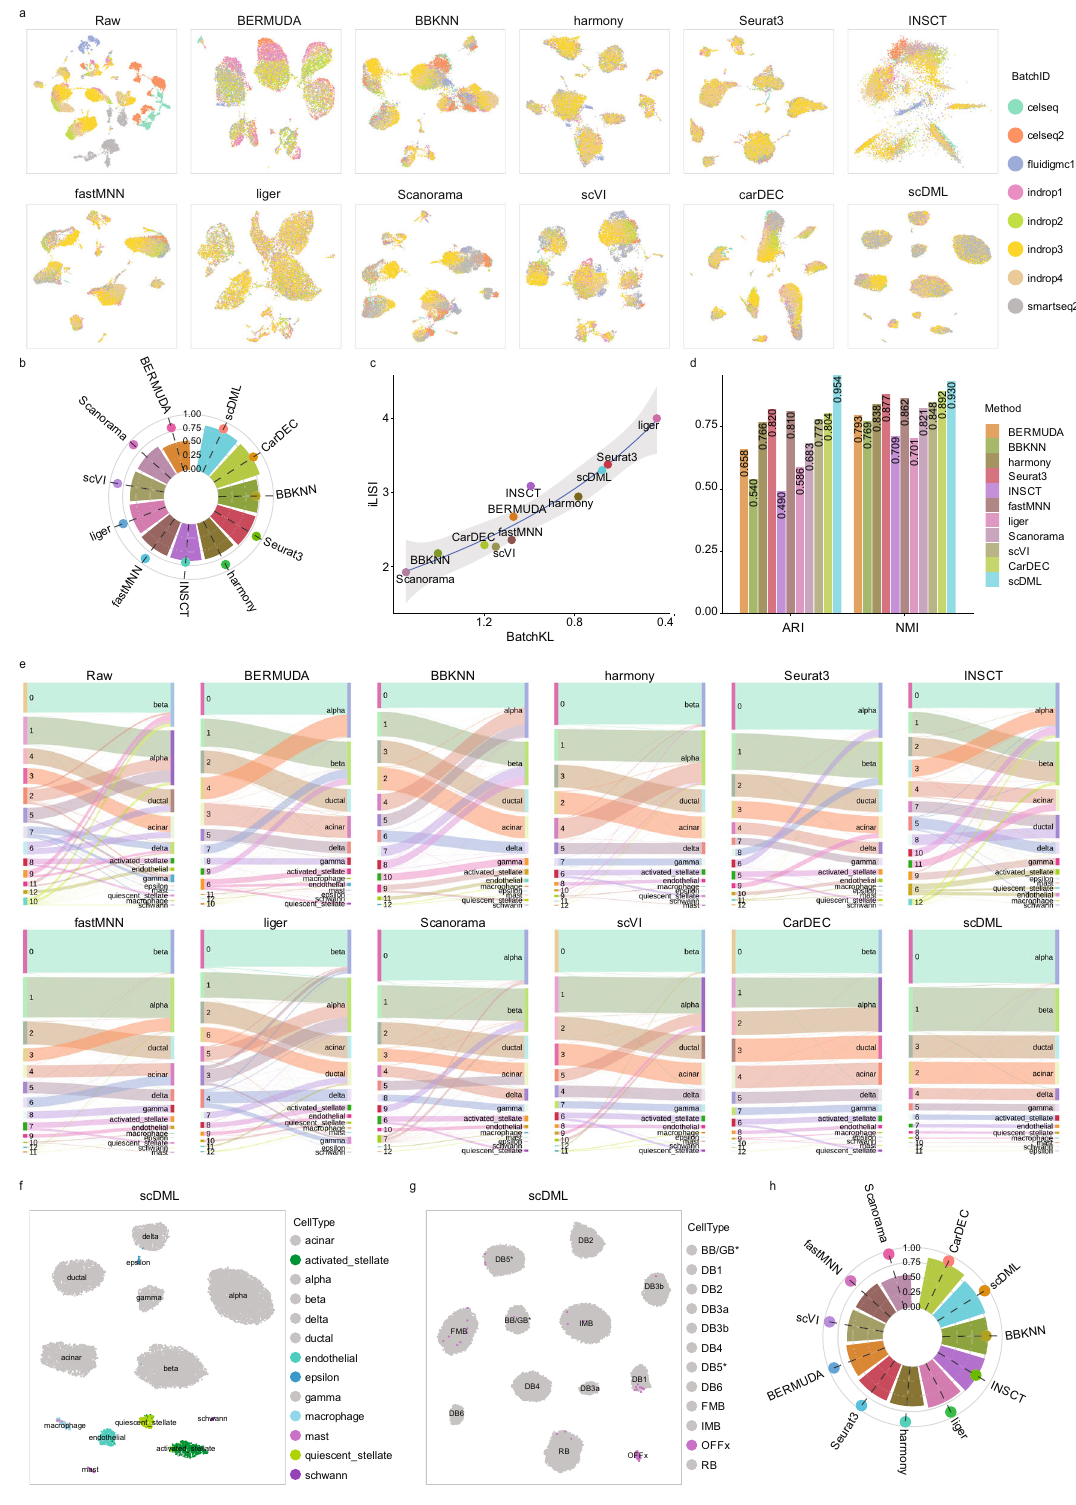
scDML was the best method that separated neurons from other cell types (Fig. 5a, b) and generated the most isolated clus- ters (Fig. S11a) with the overwhelming highest ARI and NMI (Figs. 5c, S11d). The metrics BatchKL and iLISI of scDML were only inferior to Liger (Fig. S11c), but Liger sacri fi ced clustering accuracy (Fig. 5c). Other compared methods failed to maintain relatively good cell type separation or batch mixing (Fig. S11b, c). We